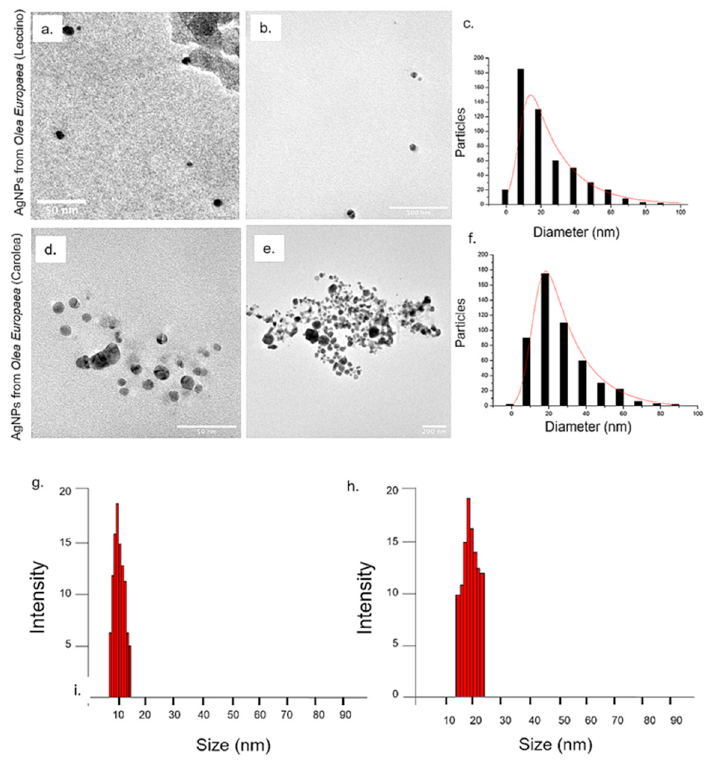
Figure 2. Representative TEM images of AgNPs obtained from Olea Europaea ( a – b ) Leccino and ( d – e ) Carolea at pH 8. Size distribution was measured on 500 AgNPs from Leccino ( c ) and Carolea ( f ) and fitted with a normal function (solid line). DLS measurements in water of AgNPs from Leccino ( g ) and Carolea ( h ) at pH 8.